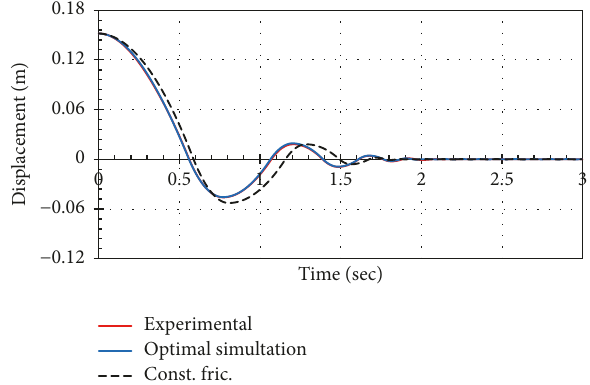
Figure 18: Simulation time history of displacement for the friction functionofmeasuringdisplacementandindividualbestfitandover- all best fitting function (WD40 whipped with initial displacement of 151.83